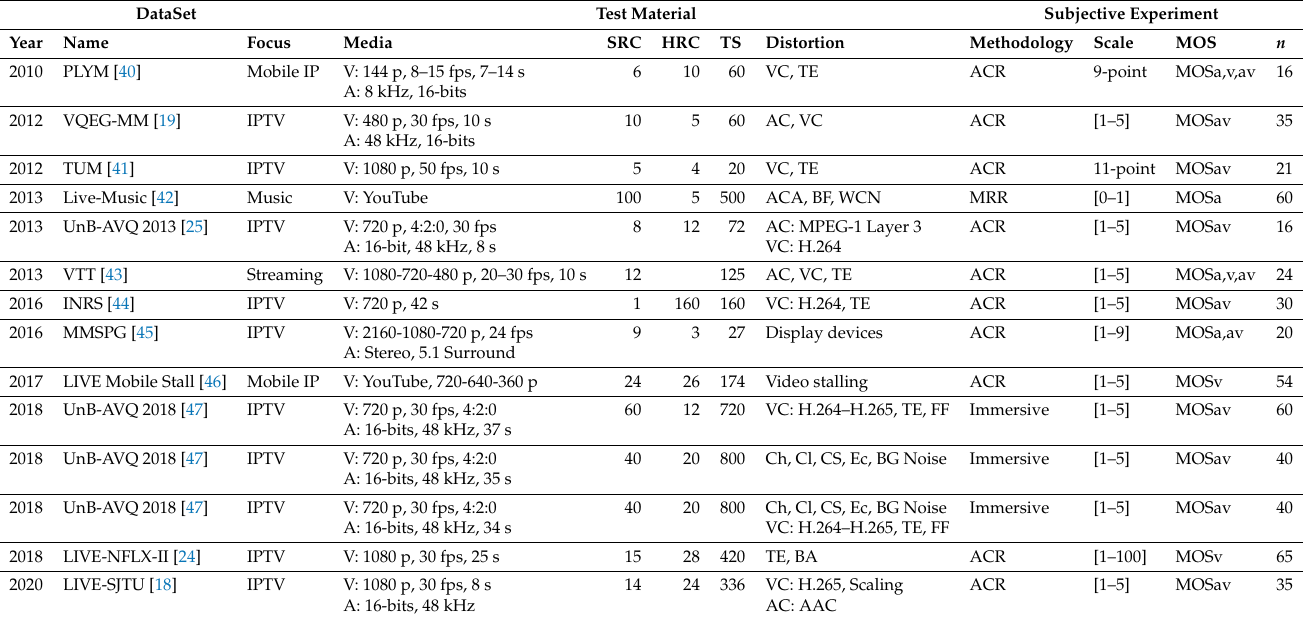
Table 2. Audio-visual quality assessment databases and perceptual studies. A: Audio; S: Speech; M: Music; V: Video; A/V: Audio-visual; TT: Telephone transmission; SRC: Source stimuli; HRC: Hypothetical reference circuit; TS: Test sequences; n : Number of subjects; BG: Background noise; AC: Audio compression; CS: Competing speaker; Ec: Echo; Ch: Chop speech; Cl: Clipping; ACA: Amplitude compression and amplification; BF: Butterworth filtering; WCN: White and crowd noise; VC: Video compression; TE: Transmission Errors; FF: Frame Freezing; BA: Bitrate